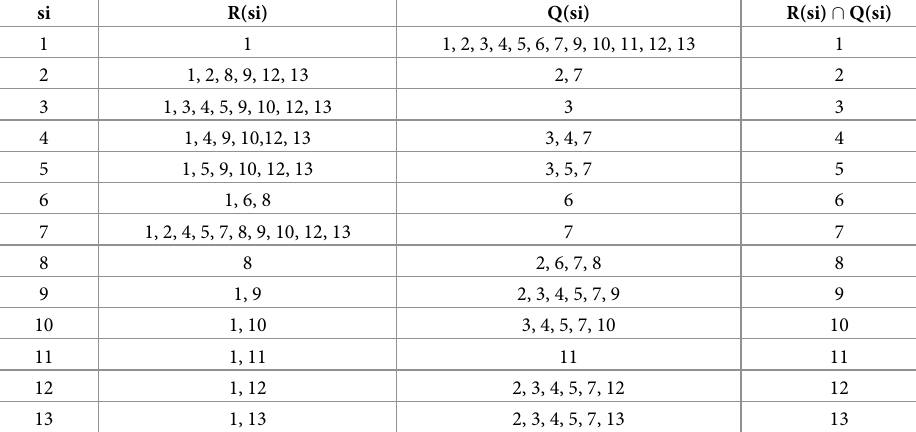
Table 4. Division of the first-level factors.